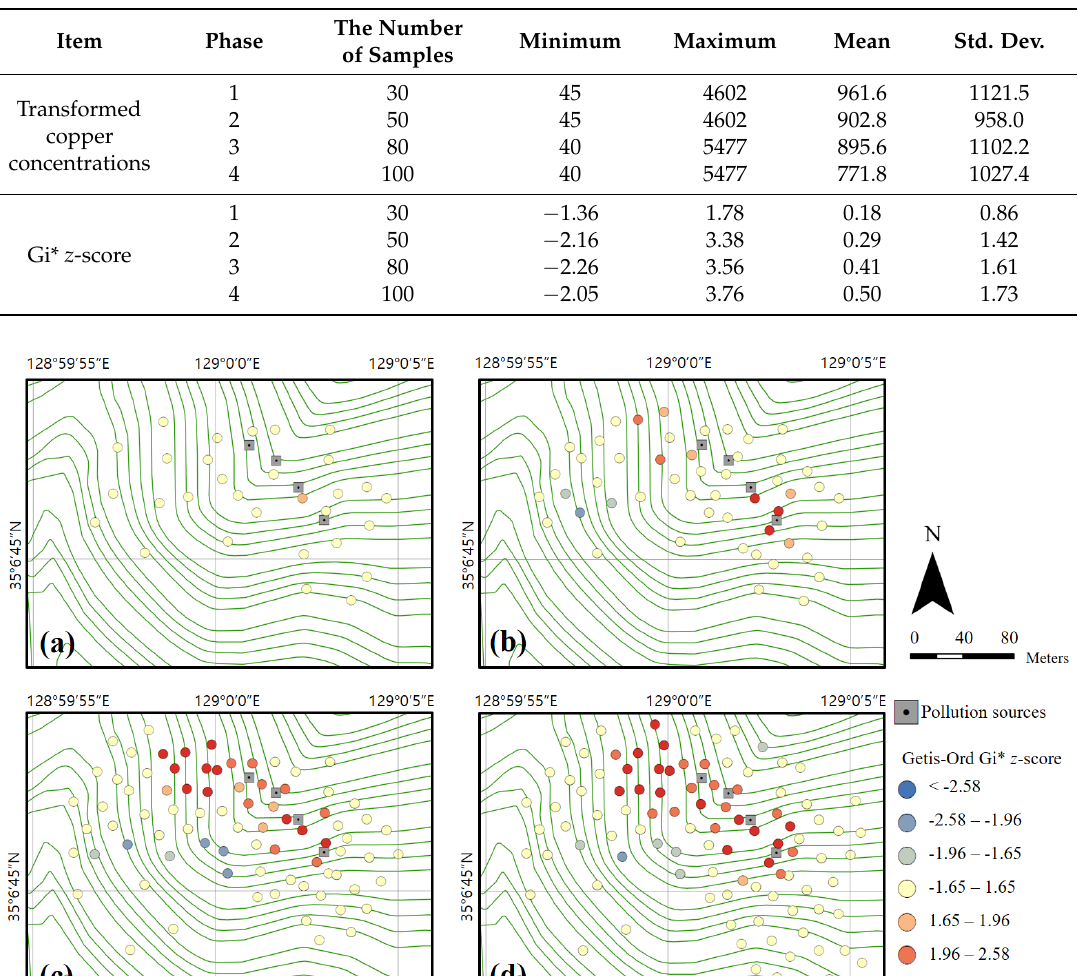
Table 2. Descriptive statistics of the transformed copper concentration and Gi* z -score results according to the four-phase procedure.